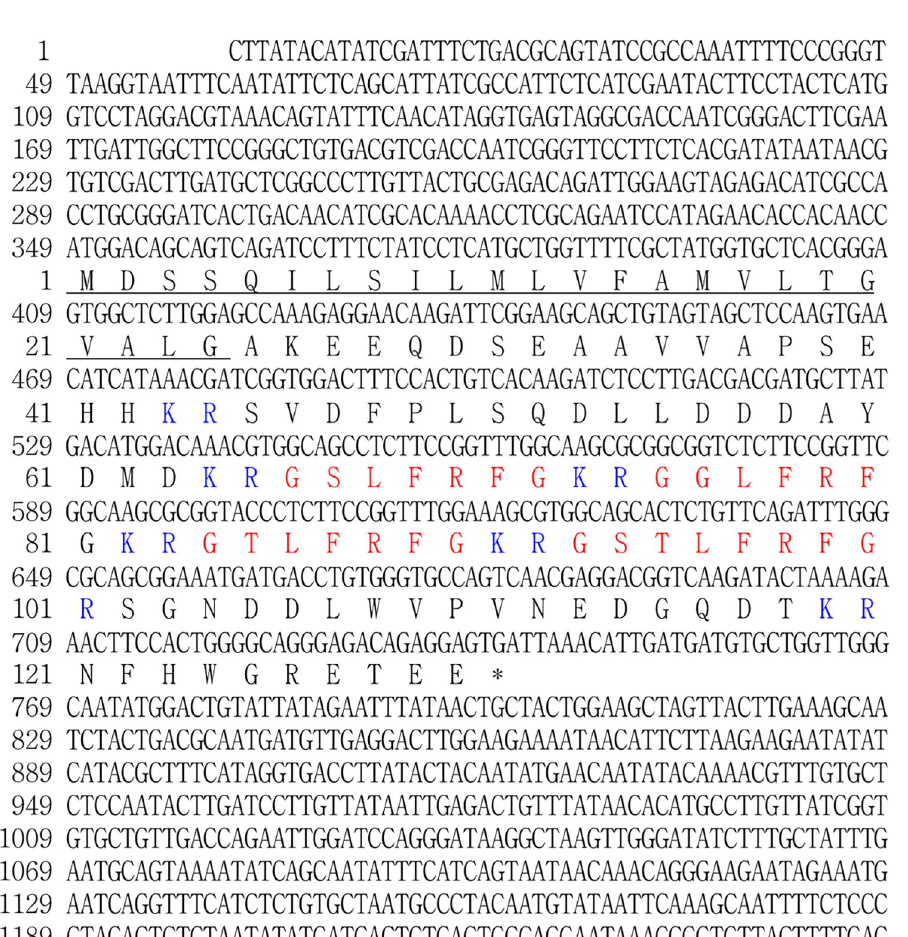
Fig 1. Nucleotide and amino acid sequences of Haliotis discus hannai LFRFamide (Hdh-LFRFa) precursor. Nucleotides and amino acids of Hdh-LFRFa precursor are numbered on the left. The predicted signal peptide sequence, mature Hdh-LFRFa peptides, and dibasic cleavage site residues are shown in underlined, red, and blue letters, respectively. The stop codon and polyadenylation signal are denoted by an asterisk and a double-underline, respectively. The nucleotide sequence for Hdh-LFRFa precursor has been deposited in the NCBI GenBank database (accession no. OL804262).